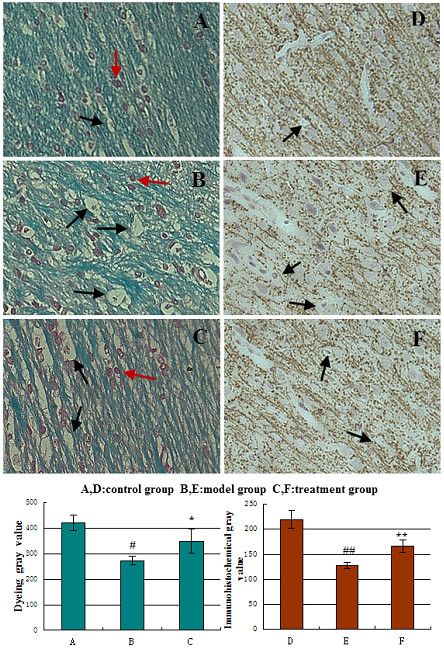
Myelin nerve fibers in parietal white matter of rats, FGS × 400. Normal myelin (A) showed cord-like, dark green, tightly packed, and cells was red (Red arrow); it showed myelin fibers loose and light-stained, glial cell vacuolation (Black arrow) after modeling (B). In model group, myelin gray value (MGV) decreased significantly than that in control group (#P < 0.05 vs control group) and increased significantly than that in model group after treatment (C) (*P < 0.05 vs model group). The expression of MBP in parietal white matter, SABC × 400. In the control group (D), myelin fibers was arranged closely and tidy. After modeling (E), myelin degeneration release and disordered, positive cells showed cytoplasmic uneven coloring, and vesicular (Black arrow). The MBP expressed significantly lower in model group (##P < 0.05 vs control group) and increased significantly and myelin fibers tightly packed in treatment group (F) (**P < 0.05 vs model group).